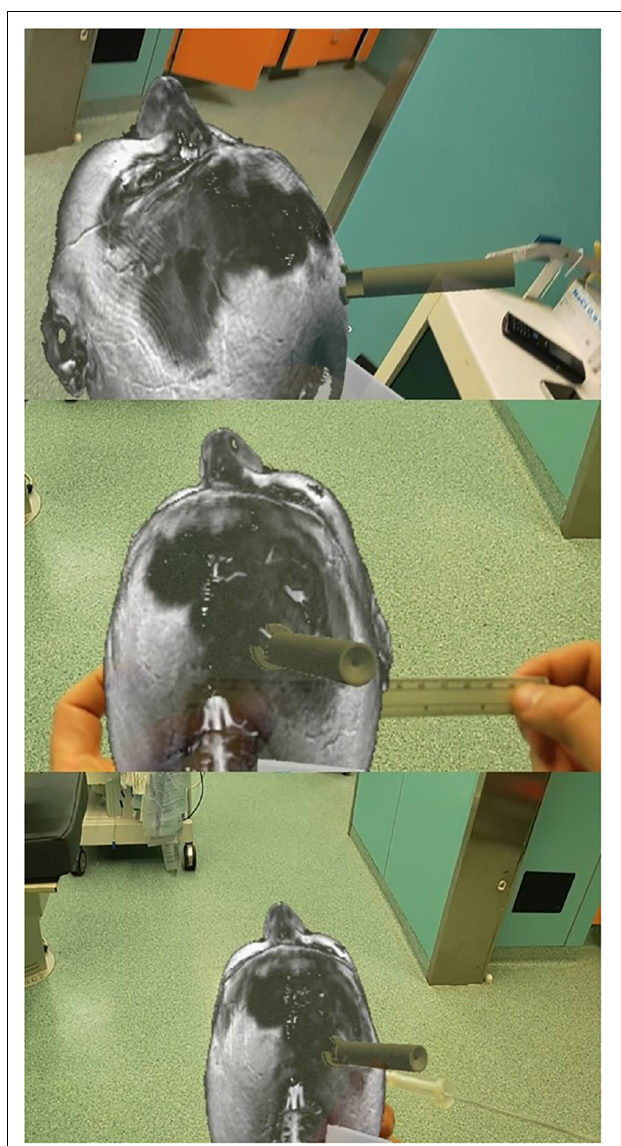
FIGURE 6 | Augmented reality-based simulation (ApoQlar) to locate the entry point. A real ruler was overlapped on the hologram based on both MRI and CT scans; the actual device was overlapped over its holographic reconstruction, and the navigated stylet was introduced to improve familiarity with the procedure and